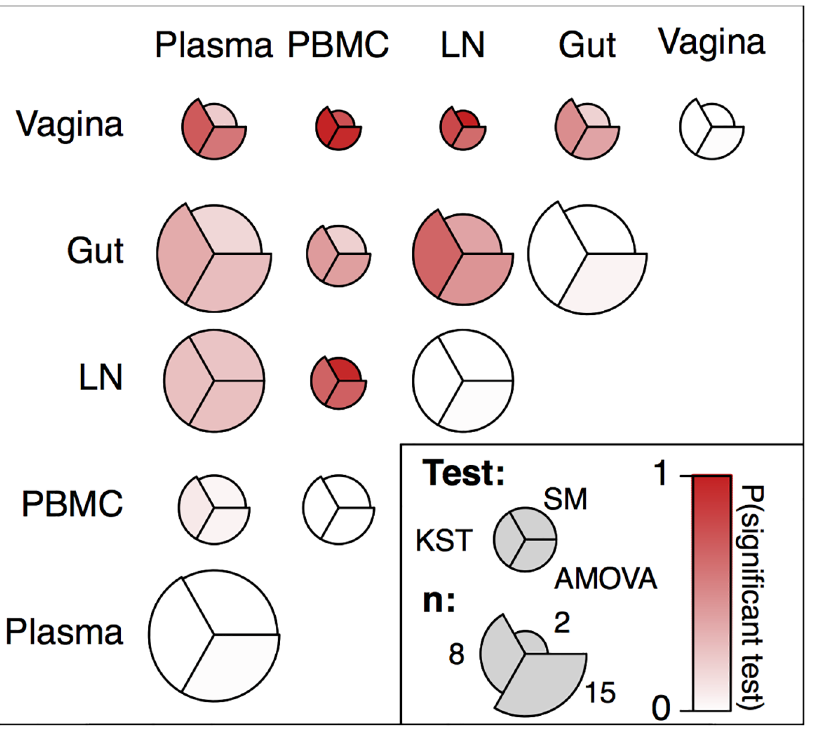
Fig 7. Compartmentalization test results reveal pairwise RT-SHIV RNA compartmentalization relationships between blood, lymph node, gut, and vagina. Each circle summarizes the results of three compartmentalizationtests performed pairwisebetweenthe vRNA from compartments withina macaqueat a giventime, andthe positionof the segmentrepresentsthe test performed (left: KST, top-right:Slatkin-Maddison (SM), bottom-right: AMOVA). The colorationindicates the probabilityof a significanttest resultat the 5% significance levelwhensubsampling10sequencesfrom eachcompartment averagedacrosseachmacaque andall time pointswith red indicating a highprobabilityandwhiteindicating a lowprobabilityof a significanttest. The areaof the segmentindicates the numberof comparisonscontributingto that average(i.e., the numberof time pointswitha sufficientnumberof sequencesin eachcompartment withina macaque). Becausewe used10 uniquesubsampledsequencesto performthe SM test, the SM test couldnot be performedon somemacaque time points,resultingin smallersamplesizes(seeMaterialsandMethodsfor